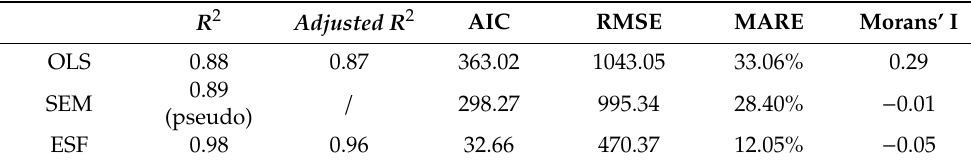
Table 9. Model performance in 2015.